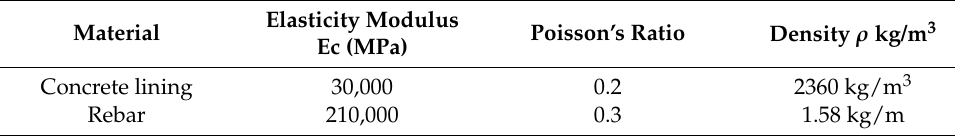
Table 3. Strength parameters of reinforced concrete